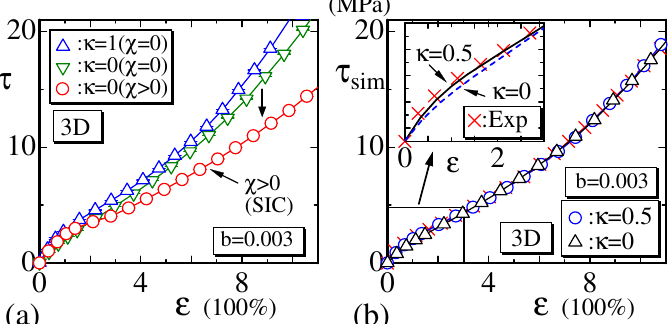
Figure 14. ( a ) The stress τ vs. ε obtained by the 3D model with the crystalline state ( (cid:13) ) and without the crystalline state ( (cid:52) , (cid:79) ), and ( b ) the stress τ sim vs. ε obtained without the crystalline state. The stress τ in ( a ) has the simulation unit, which corresponds to k 3 = 1 and is not modified by the factor k B T B T / a in Equation (13), while the stress τ sim in (b) has the real physical unit (MPa) and is modified by the factor k B T / a 3 . Experimental data denoted by Exp ( × ) in ( b ) are XL5, the same as in Figure